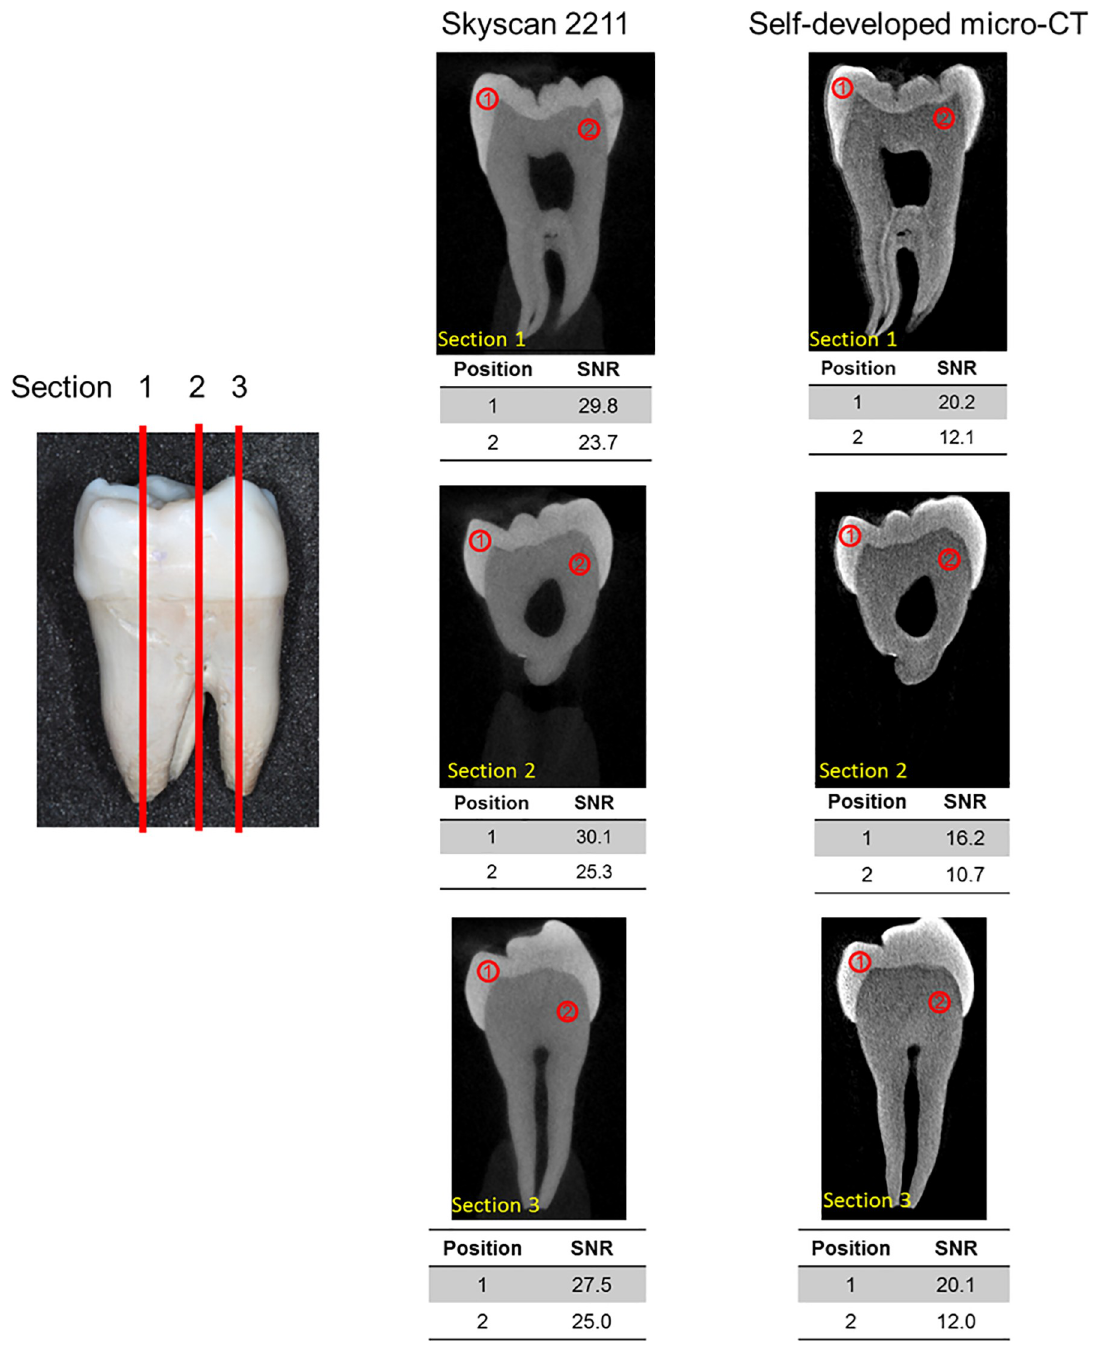
Fig 4. Quantitative analysis of the three buccal-lingual reconstructed images of the third molar captured with (left) the Skyscan 2211 and (right) the self-assembled micro-CT system. SNR, signal-to-noise